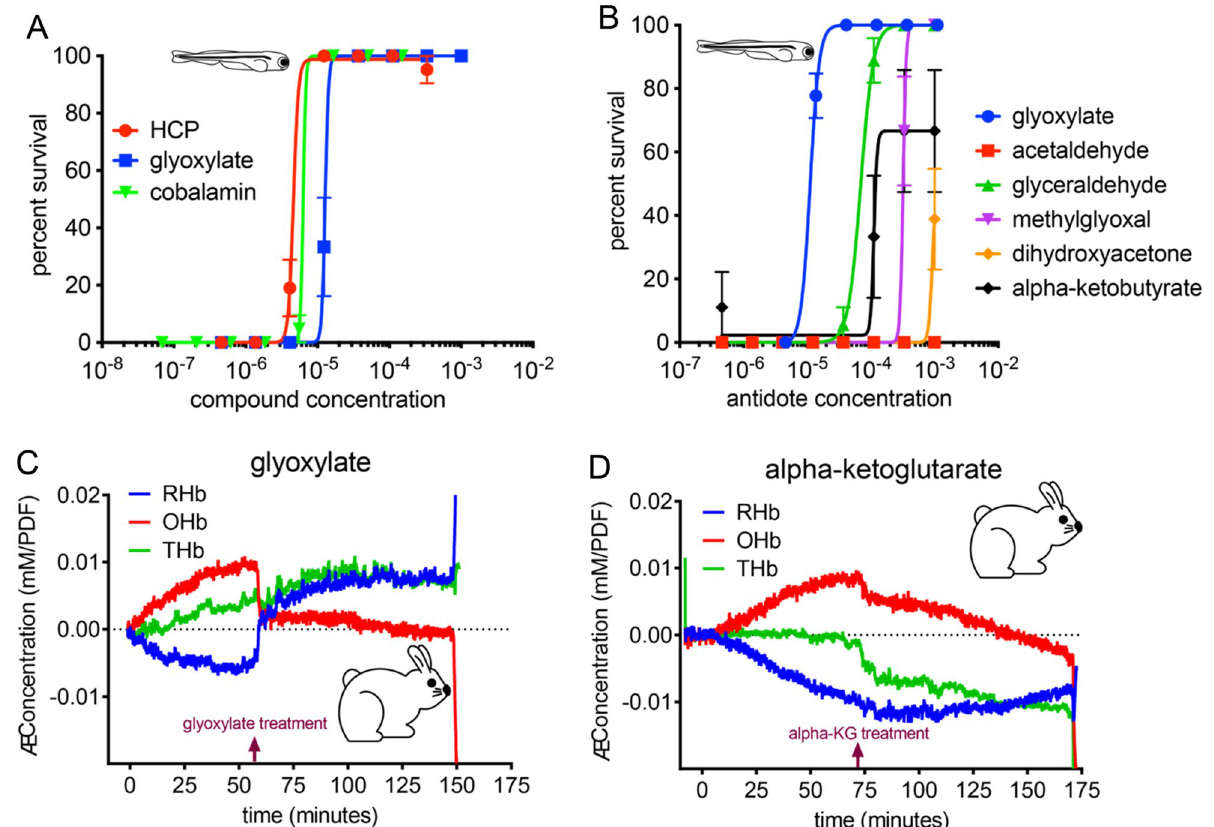
Figure 4. Glyoxylate’s rescue mechanism is not fully explained by cyanohydrin formation. Dose dependent survival of 5 dpf zebrafish in the presence of ( A ) scavengers (3 fish per well, N = 6 wells for each condition) or ( B ) cyanohydrin-forming molecules 20 h after exposure to 20 µM KCN (3 fish per well, N = 6 wells for each condition with the exception of alpha-ketobutyrate, N = 3). Data presented as mean ± SEM. HCP was 100% lethal at the highest dose (1 mM) and this data point was removed to preserve an accurate dose–response curve. ( C ) Continuous-wave near-infrared spectroscopy (CWNIRS) monitoring changes in concentrations of deoxygenated (RHb), oxygenated (OHb), and total (THb) hemoglobin. The rabbits were exposed to a sublethal dose of 10 mg i.v. NaCN for 60 min. At 60 min, subjects received equimolar doses of glyoxylate or ( D ) alpha- ketoglutarate (100 mg or 147 mg respectively). Results shown are typical of the response seen by CWNIRS in animals treated with cyanide and